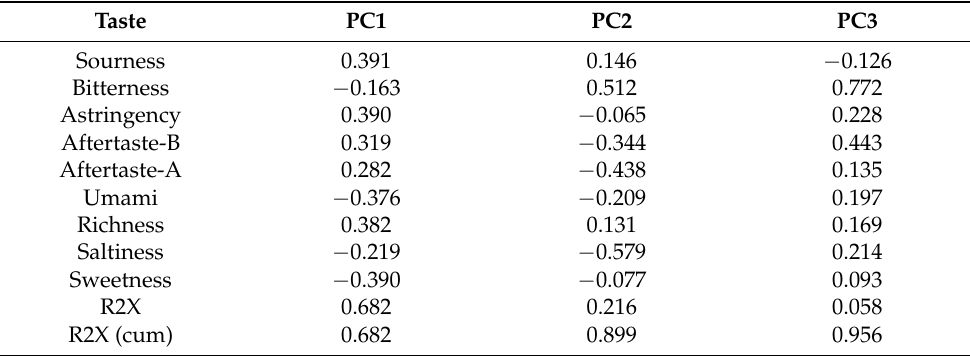
Table 2. Principal component factor loading for E–tongue